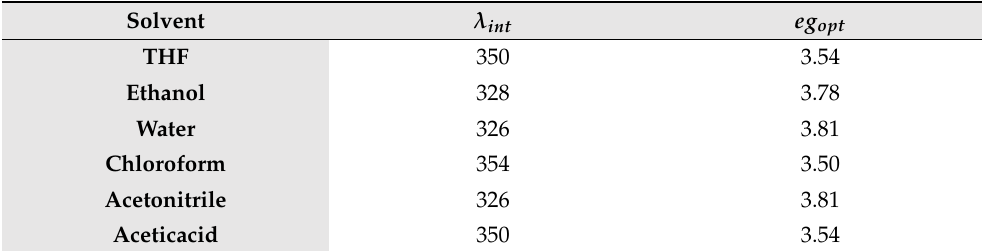
Table 5. Computed intersection wavelength ( λ int , nm) and optic energy gap B3LYP/6-31+G(d) level as a function of several